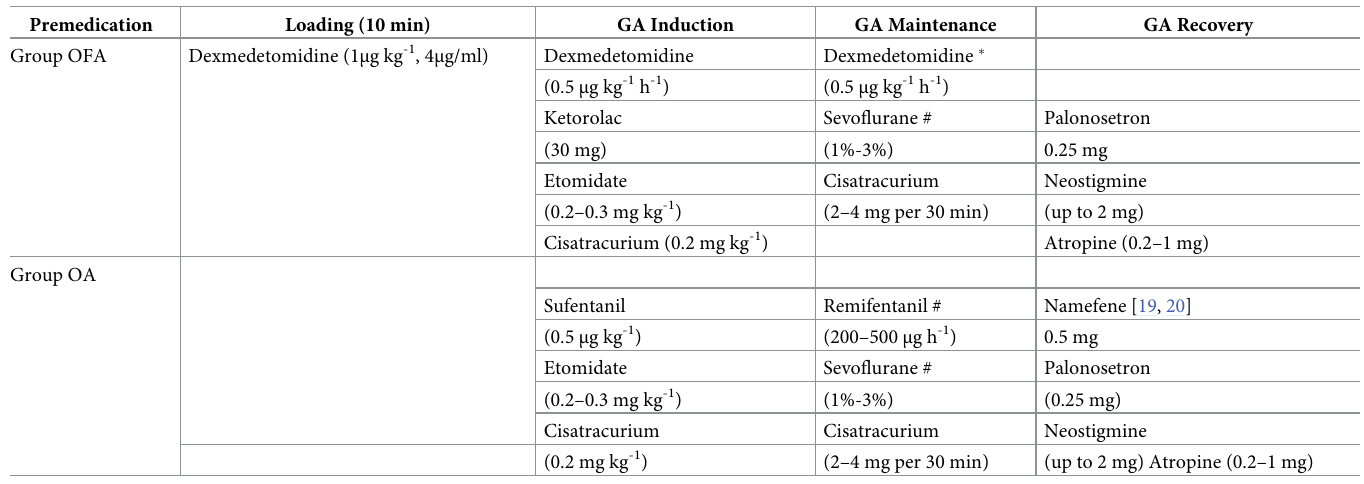
Table 1. Time chart of anesthetic